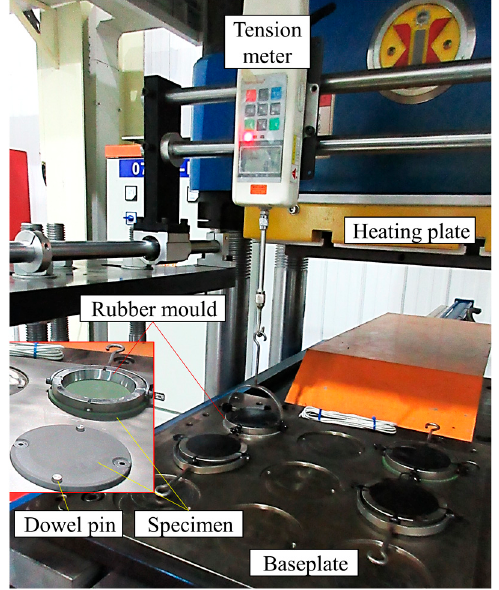
Figure 3. Plate vulcanizing press machine.